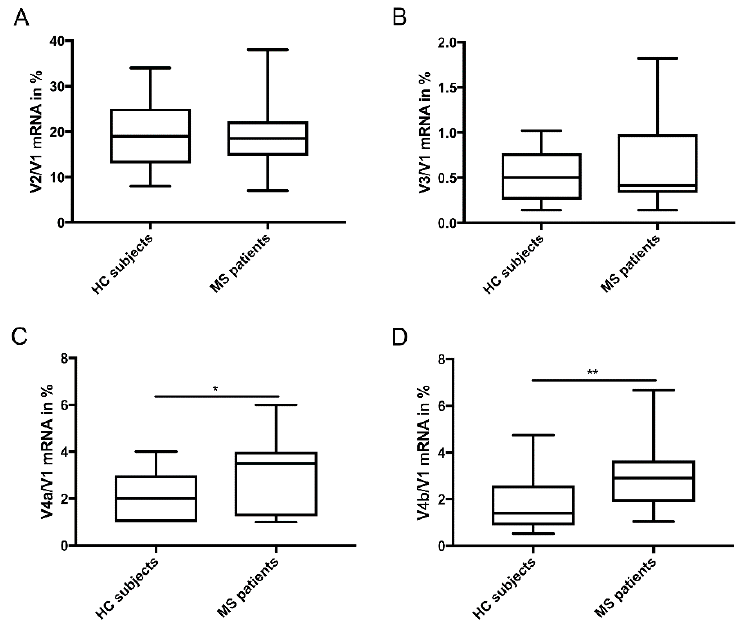
Figure 2. mRNA levels of TG2 short isoforms as percentage of V1 full length mRNA. ( A ) Percentage of V2 expression over V1 mRNA (HC: N = 30/PP-MS: N = 22); ( B ) Percentage of V3 expression over V1 mRNA (HC: N = 18/PP-MS: N = 12); ( C ) Percentage of V4a expression over V1 mRNA (HC: N